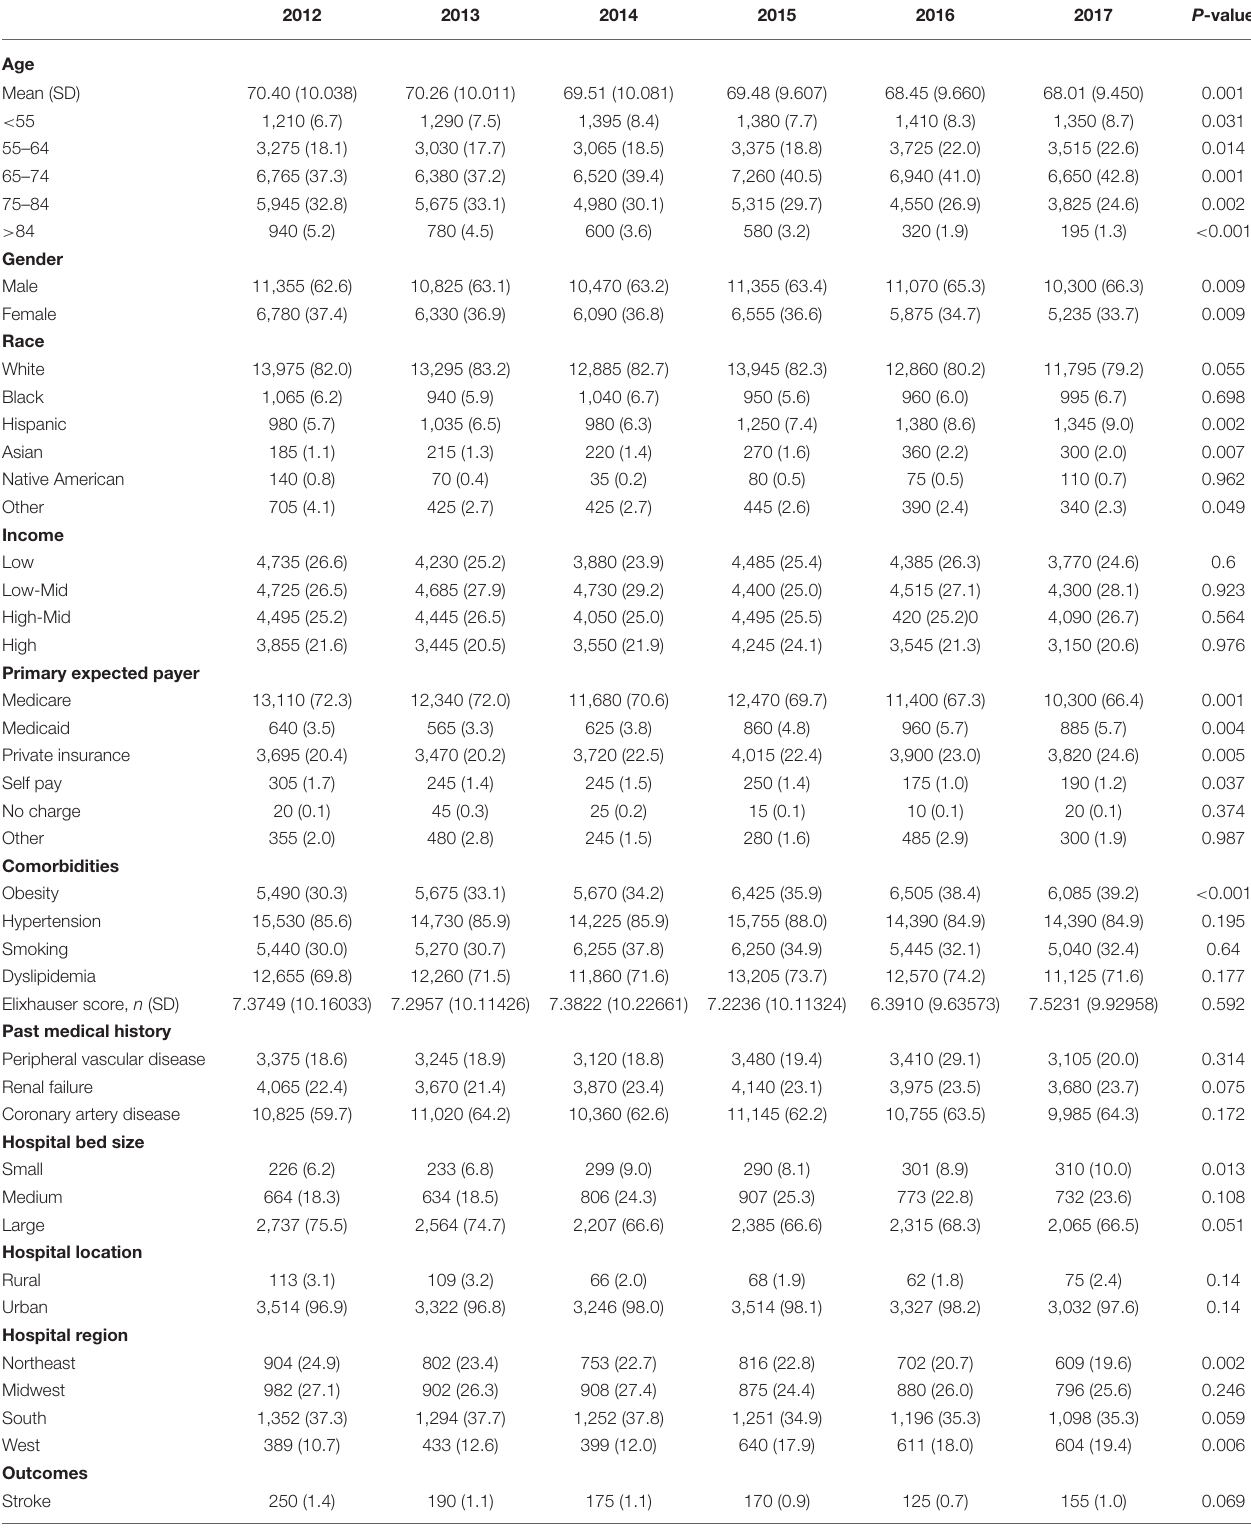
TABLE 4 | Baseline characteristics of patients with diabetes undergoing